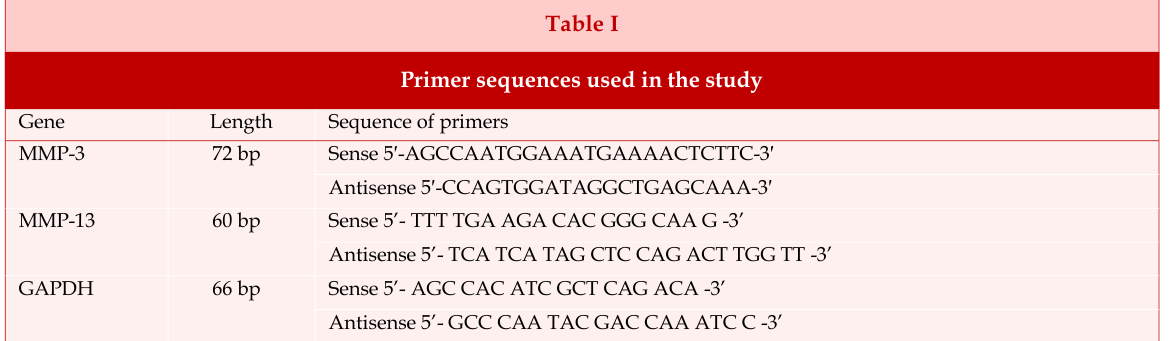
Primer sequences used in the